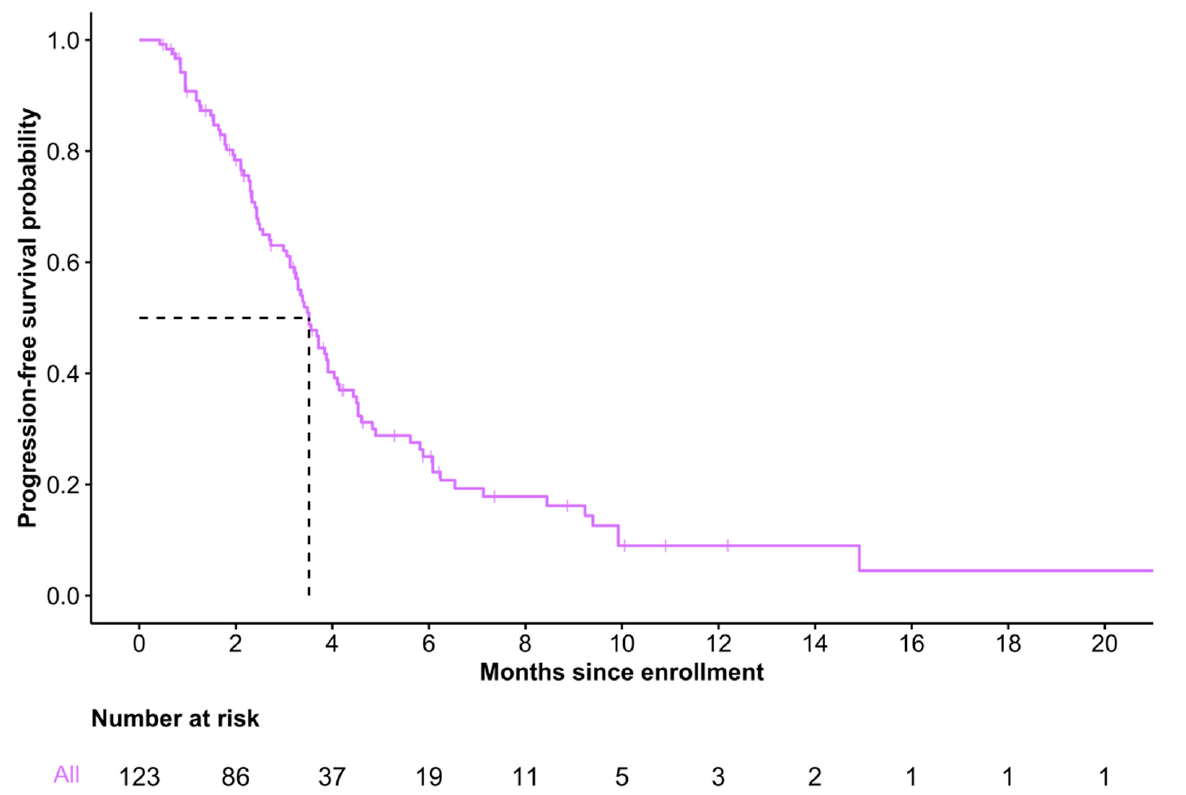
Figure 3. Progression-free survival of patients who initiated trifluridine/tipiracil. Treatment discontinuation due to disease progression or physician decision occurred more frequently among patients who received at least two cycles of FTD/TPI, whereas treatment discontinuation due to adverse events was more frequent among patients receiv- ing less than two cycles (Table 3). Other differences between treatment duration subgroups showed no statistical significance. Table 3. Characteristics of patients who have received and discontinued trifluridine/tipiracil treat- ment, stratified by treatment duration .